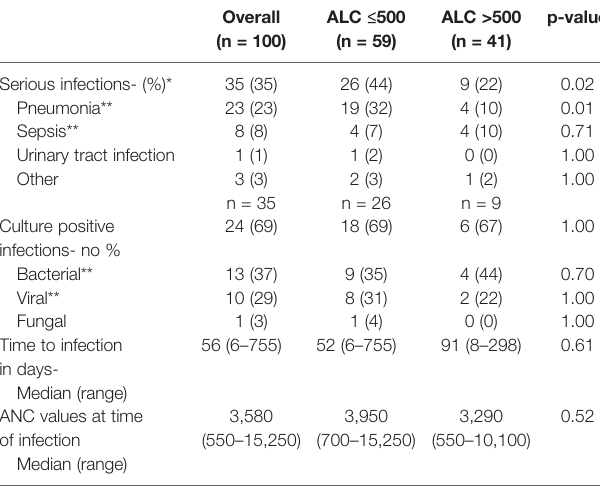
TABLE 2 | Serious infection characteristics in all patients (n =